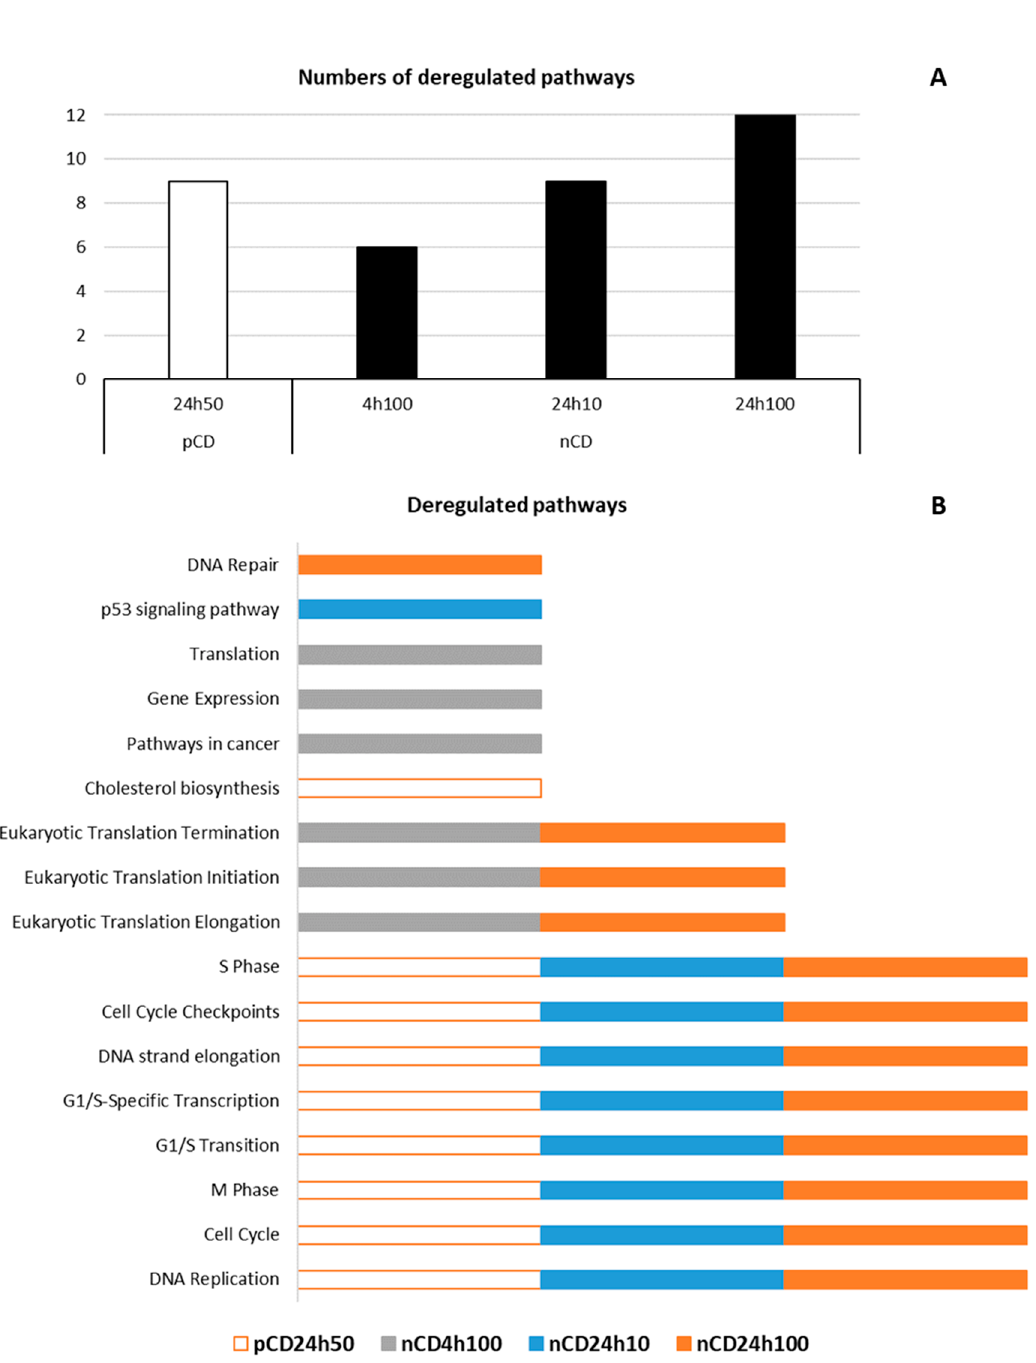
Figure 9. The graphically illustrated overview of deregulated pathways after CD NPs exposure. ( A ) indicates the number of deregulated pathways, meanwhile ( B ) shows in which exposure conditions the selected pathways are deregulated (empty rectangles denote pCD exposure, filled rectangles denote nCD exposure).